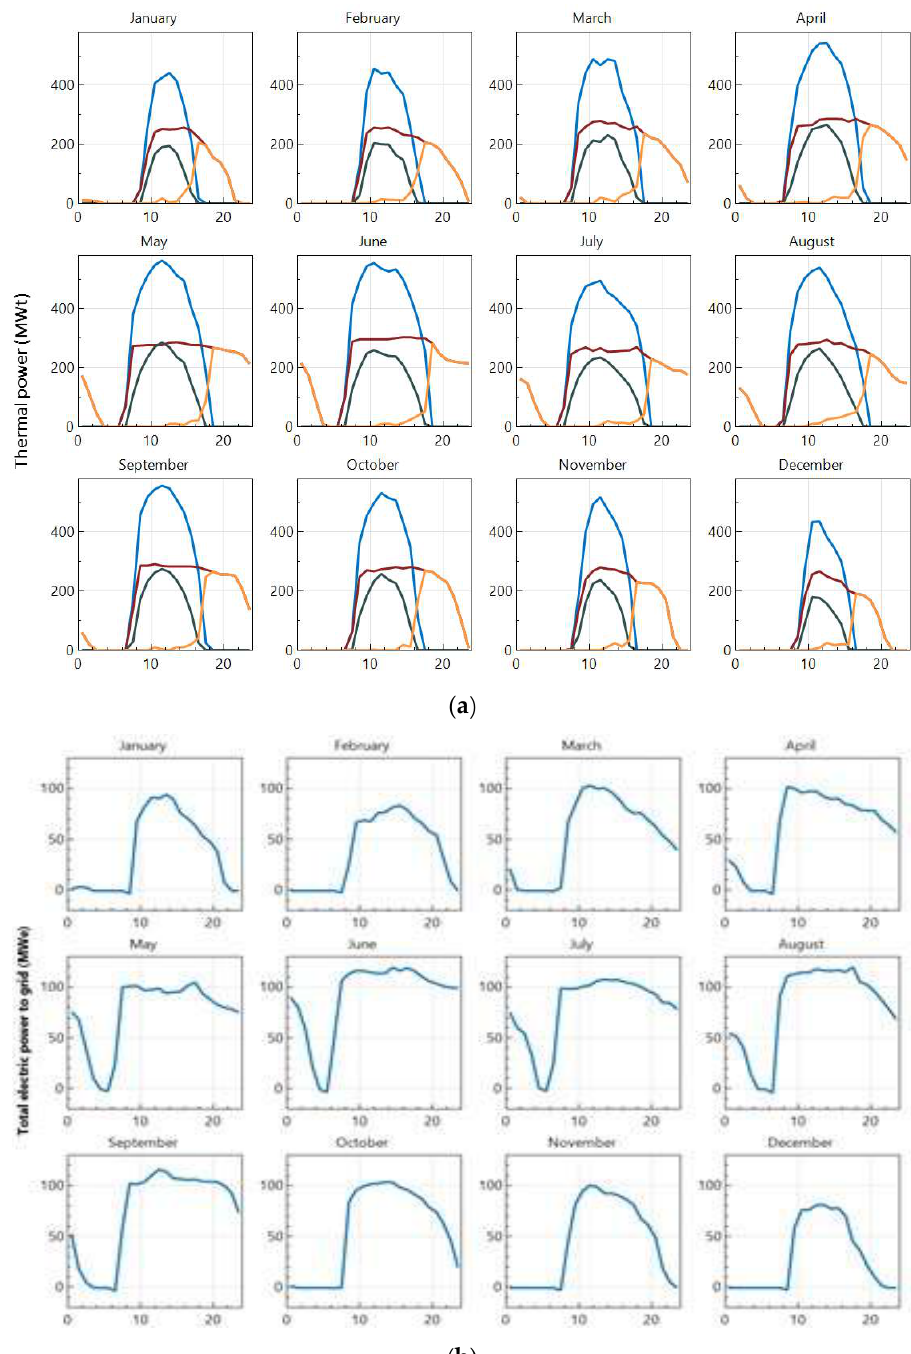
Figure 11. Crescent Dunes solar facility. ( a ) Computational thermal power produced by the solar field, the thermal energy storage power in and out, and the thermal power input to the power cycle. ( b ) Computational net power output from the turbine in the average day of every month. The model for parabolic trough and the model for the solar tower have different outputs for the thermal energy storage. The solar tower has the charges and discharges separated. The parabolic trough has a single curve. X is the time of day in hours and Y the power in MW.